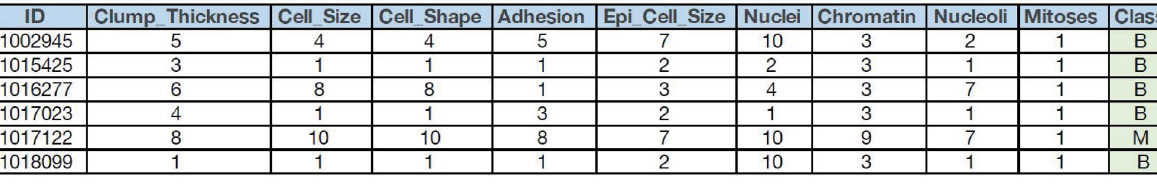
Fig 1. A sample of the dataset.